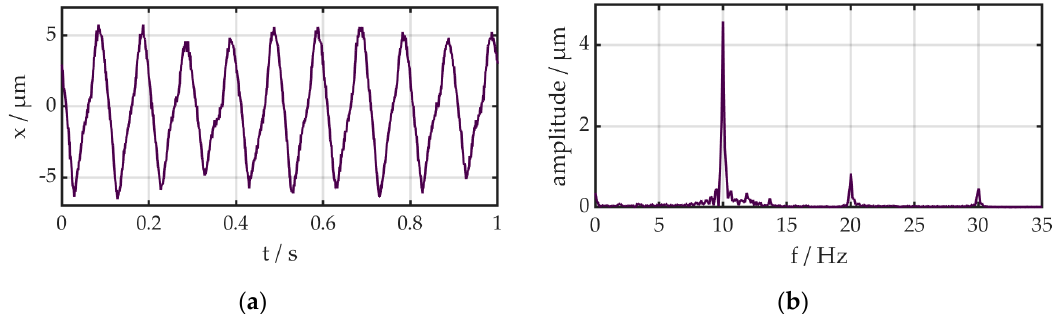
Figure 5. Displacement of the system during switching of the magnetic field but without rotation measured with a laser vibrometer: ( a ) time data, ( b ) signal in frequency domain.